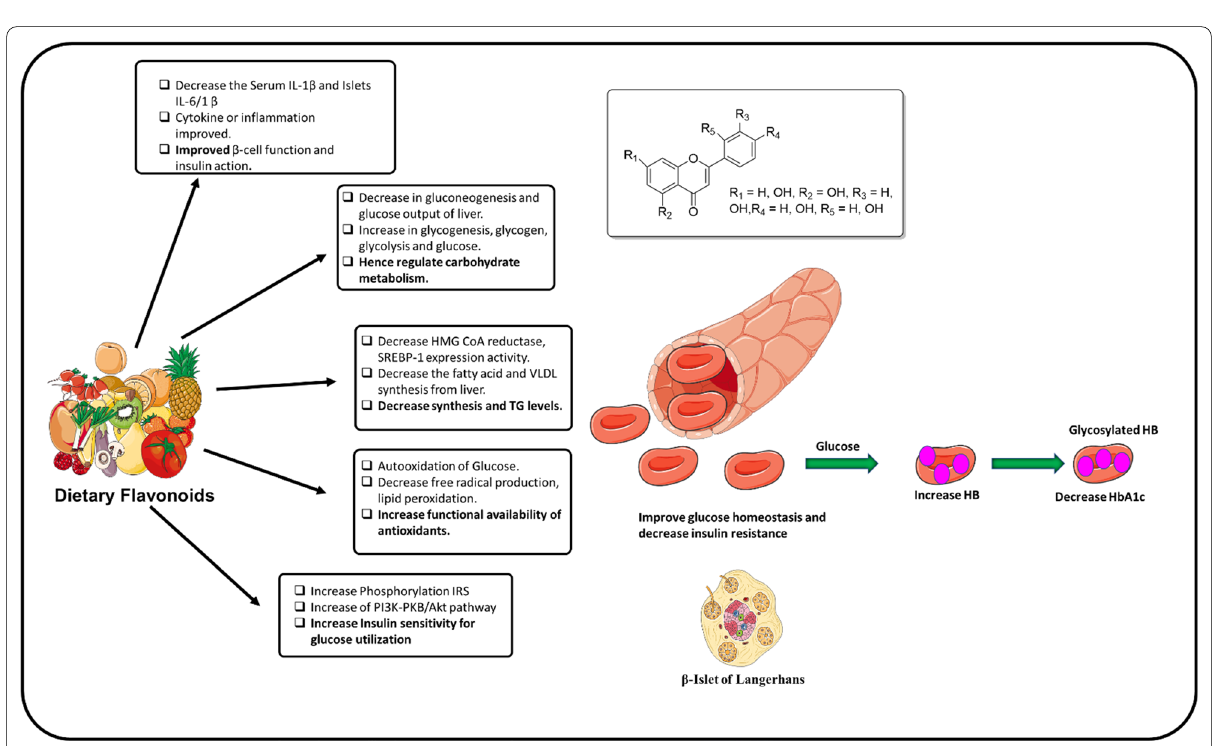
Fig. 13 Effect of B. pinnatum extracts on body weight of rats. Values are expressed as Mean control group